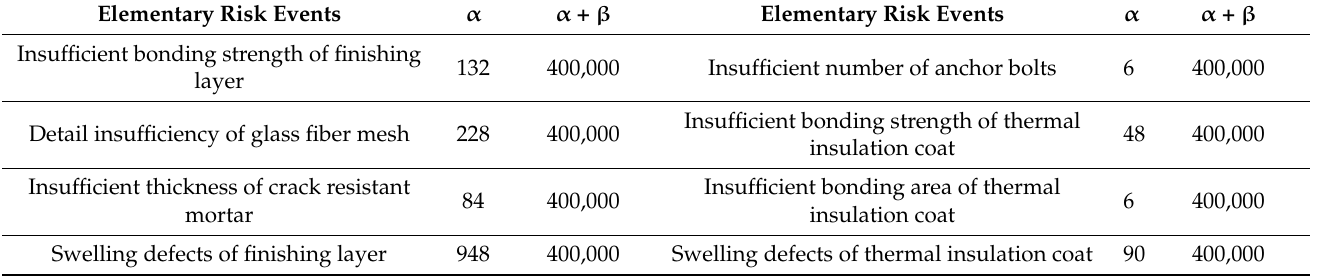
Table 3. Probability distribution parameters of elementary risk events of falling objects from façade.